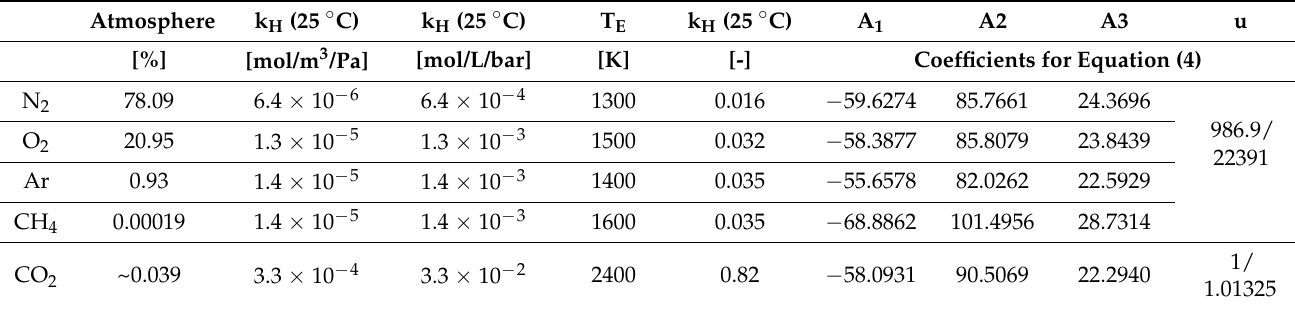
Table 1. Henry coefficients (from [19] Sander, 2015); volumetric portion in dry atmosphere (N 2 , O 2 , Ar from [20] Roedel 1992, CO 2 from [21] Worch 2015, CH 4 by [22] Saunois et al. 2020); Ostwald coefficient calculated from values in [19] and coefficients for Equation (4) for N 2 and O 2 ([23] Weiss 1970), Ar ([24] Jenkins et al. 2019), CH 4 ([25] Wiesenburg and Guinasso 1979) and CO 2 ([26] Weiss 1974); changes due to the introduction of the new temperature standard ITS-90 in 1990 are too small to show up on our scale and temperature